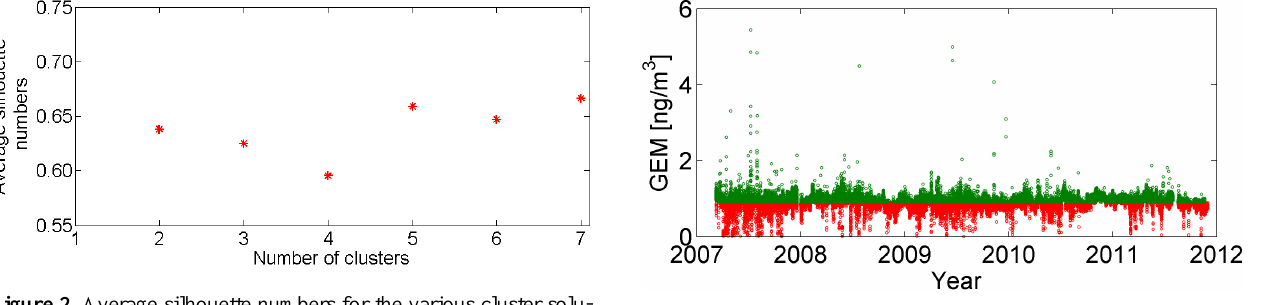
Figure 3. A scatter plot of GEM concentrations over the entire sam- pling period indicating the two main clusters. According to the clus- tering applied, division between the two clusters was at a GEM con- centration of 0.904ngm − 3 . Fig. 3. According to the clustering approach applied,